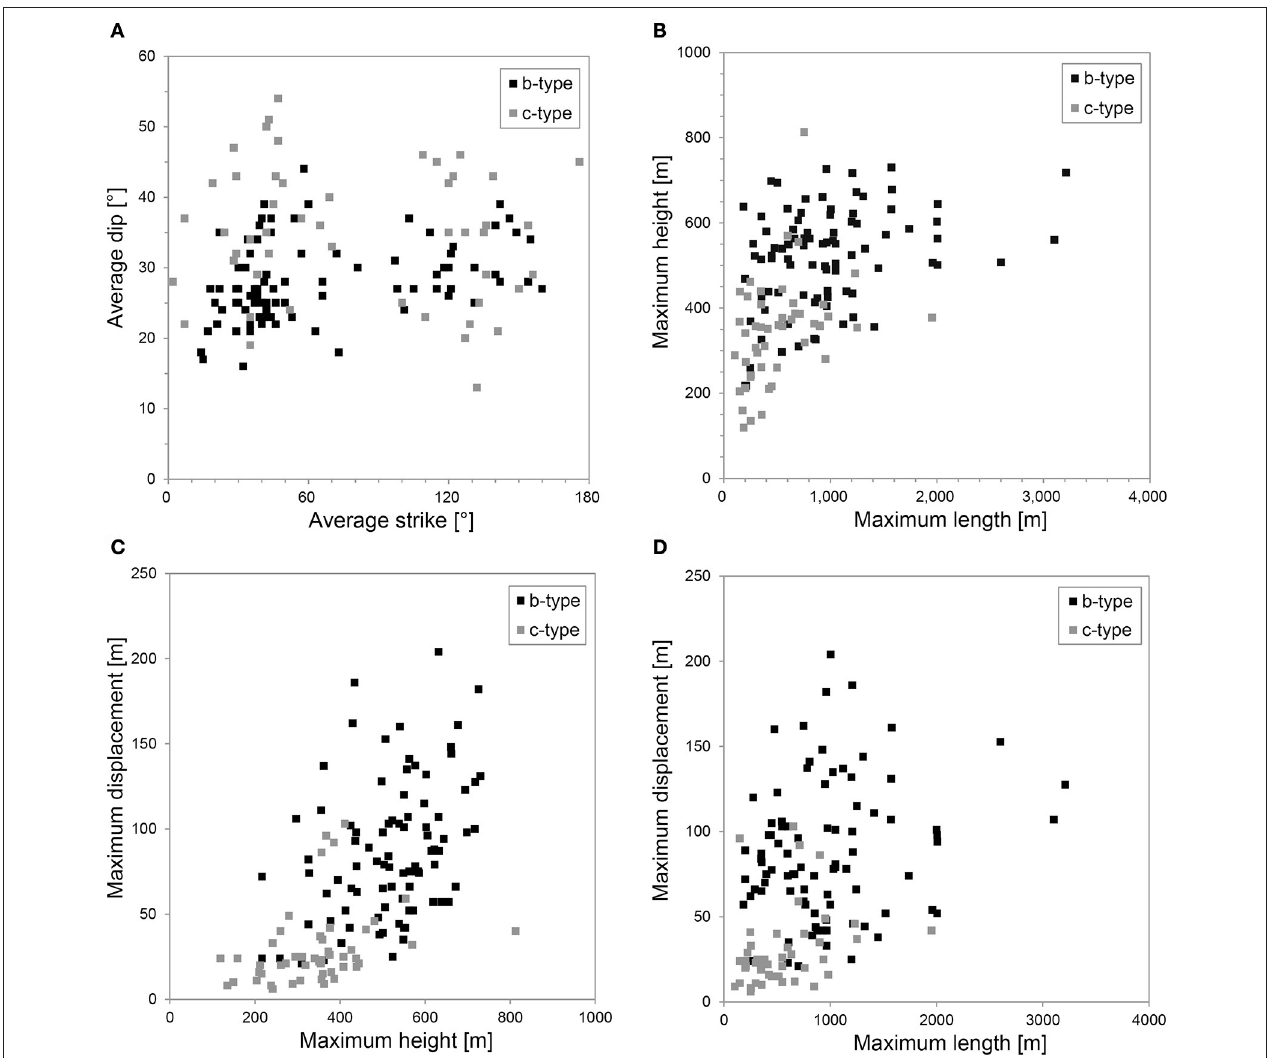
FIGURE 11 | Cross-plots of (A) average strike and dip, (B) maximum length and height, (C) maximum height and displacement, and (D) maximum length and displacement for 137 polygonal faults with b-type and c-type displacement depth profiles ( Figure 3 ). Note that these faults show no preferred orientation (A) and that b-type faults are longer, higher and accommodate more displacement than c-type faults